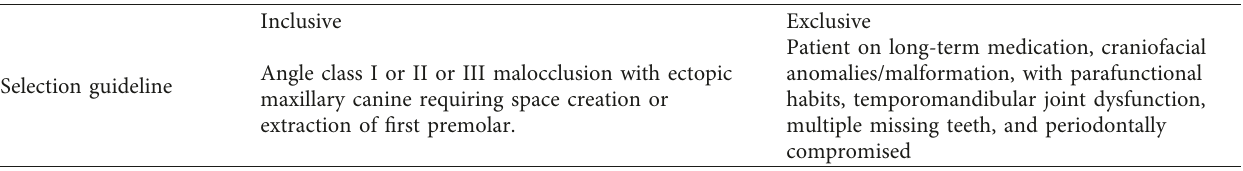
Table 1: Subjects and methodology in